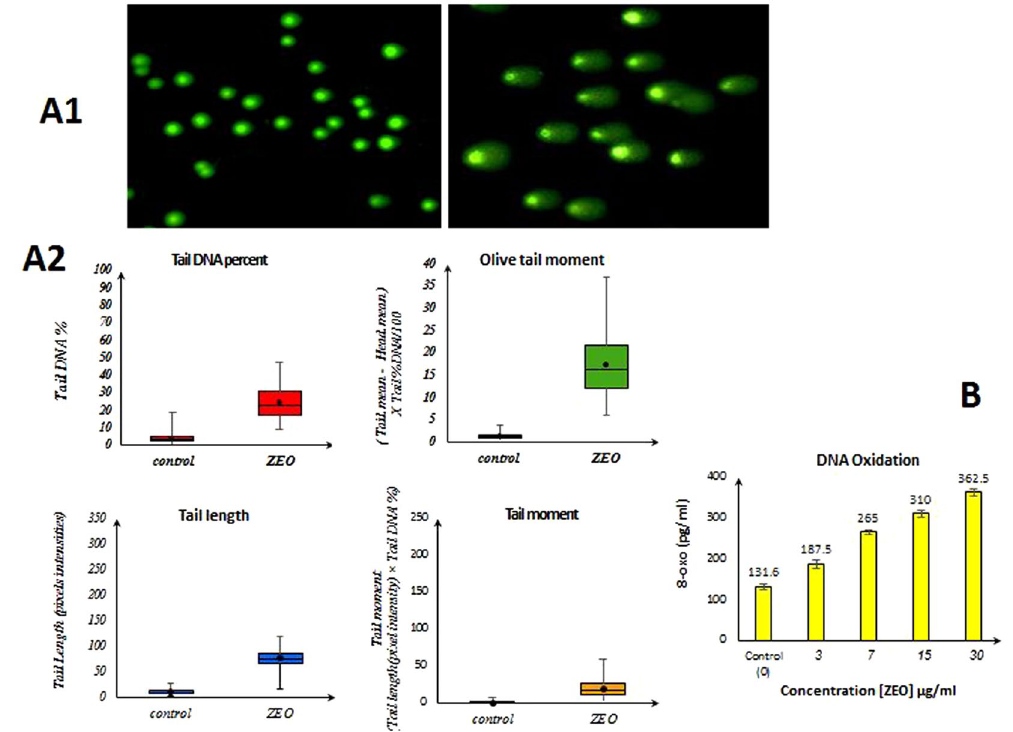
Figure 6. ZEO induces DNA damage in MDA-MB-231 cells. ( A1 ) Images of samples treated with IC50 concentration of ZEO, untreated controls and parameters measurement by Open Comet software. ( A2 ) DNA strand break results in single cells after 2 h incubation with IC50 concentration of ZEO in MDA-MB-231 cells. The comet assay results were obtained by analyzing tail DNA percentage, tail moment, tail length and olive tail moment are presented in box and whiskers plot. ( B ) MDA-MB-231 Genomic DNA oxidation produces increasing amounts of 8-oxo upon incubation with ZEO (3–30 µ g/ml) compared to untreated